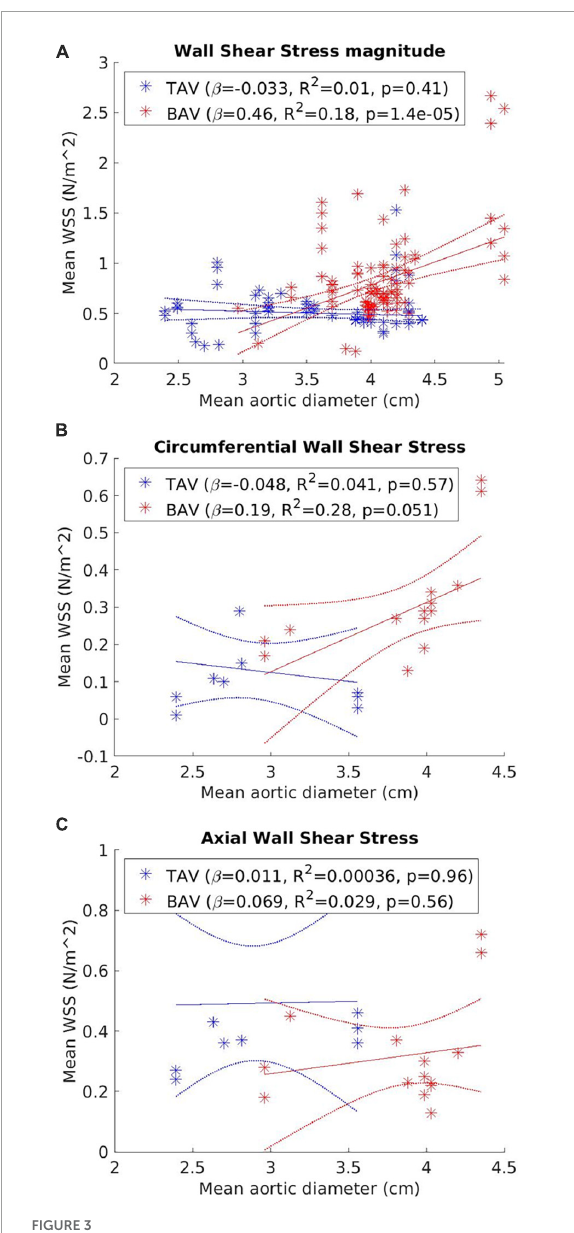
FIGURE3 Correlation between (A) wall shear stress net magnitude (WSS mag ); (B) circumferential WSS (WSS circ ); and (C) vector components axial (WSS ax ) and aortic diameter for tricuspid aortic valve (TAV) and bicuspid aortic valve (BAV) cohorts. Each data point represents a distinct WSS measurement. Line of best fit (solid line) and 95% confidence bounds (dotted line) from the weighted linear regression analysis are also